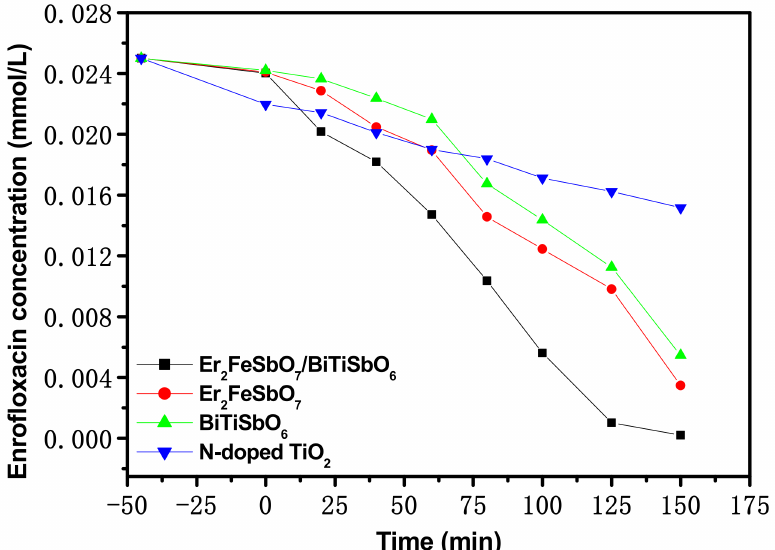
Figure 12. Concentration change curves of ENR during PCD of ENR with EBH, Er 2 FeSbO 7 , BiTiSbO 6 , or N-TO as photocatalyzer under